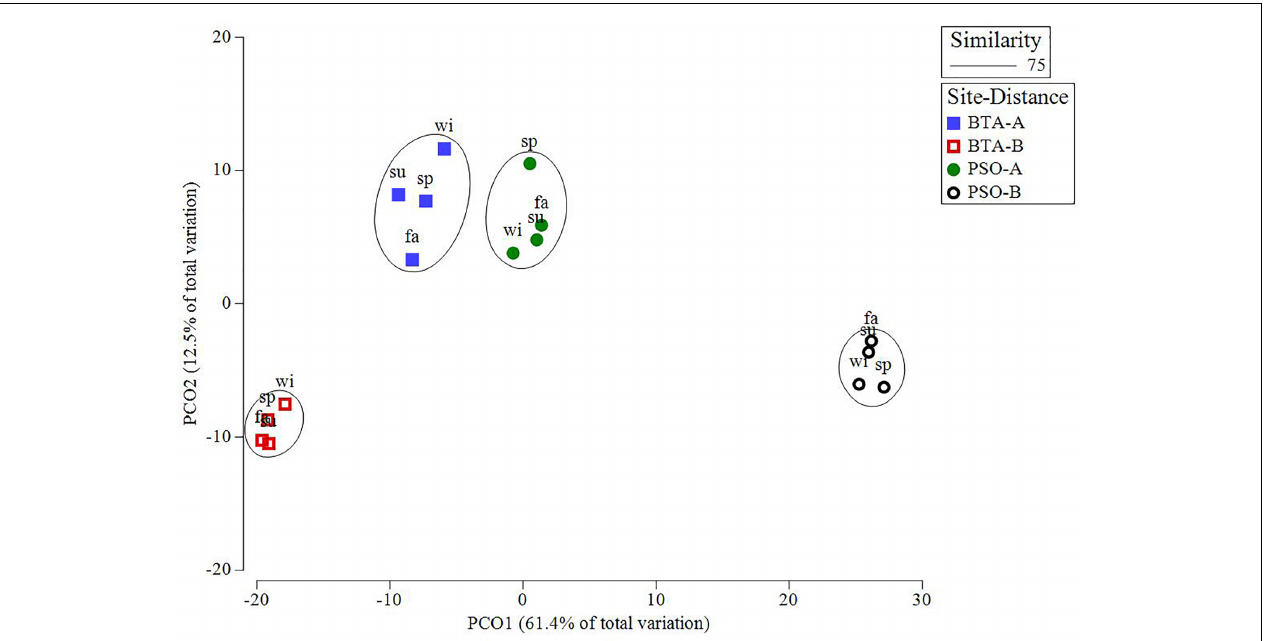
FIGURE 4 | Principal coordinates ordination (PCO) plot of distance among centroids of coral colony abundance based on Bray-Curtis similarity matrices performed on a square root-transformed data by seasons-site-distance. Clusters represent groups with 75% similarity. Seasons are defined as: sp, spring; su, summer; fa, fall; wi,